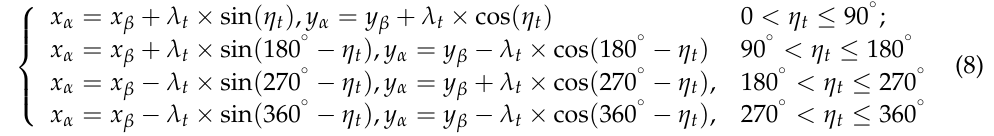
latitude coordinates of the prediction position; λ t represents predicted offset distance; α t represents the predicted